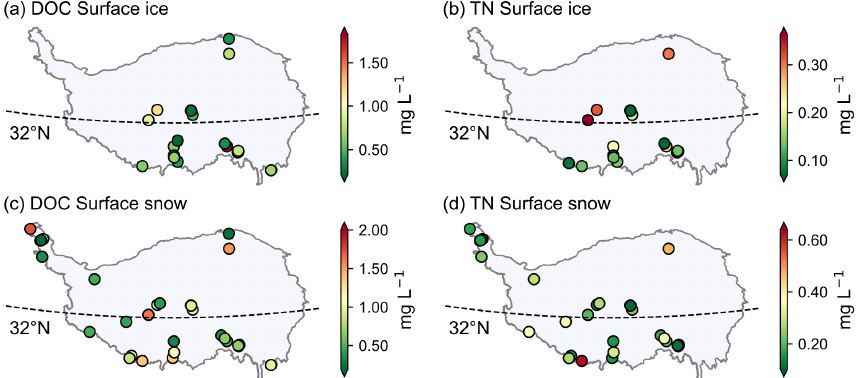
Figure 7. The spatial distribution of DOC (a, c) and TN (b, d) concentrations for surface ice (a, b) and surface snow (c, d) .